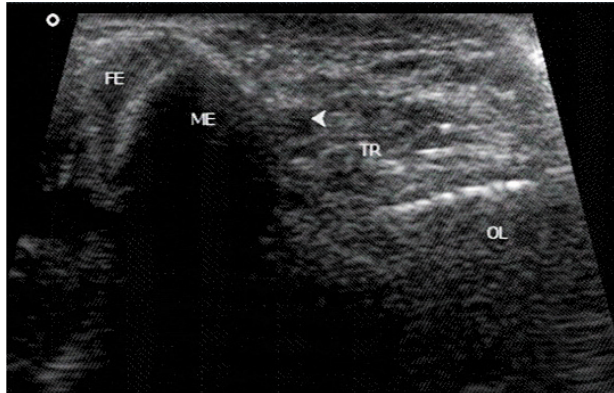
Fig. 1. The asymptomatic right elbow at the level of the cubital tunnel. The elbow is in extension. The ulnar nerve (arrowhead) and the medial head of the triceps muscle (TR) are in the cubital tunnel posterior to the apex of the medial epicondyle (ME). The common origin of the flexor muscles (FE) of the forearm is visualised at the apex of the medial epicondyle. One end of the transducer is at the medial epicondyle and the other at the head of the olecranon